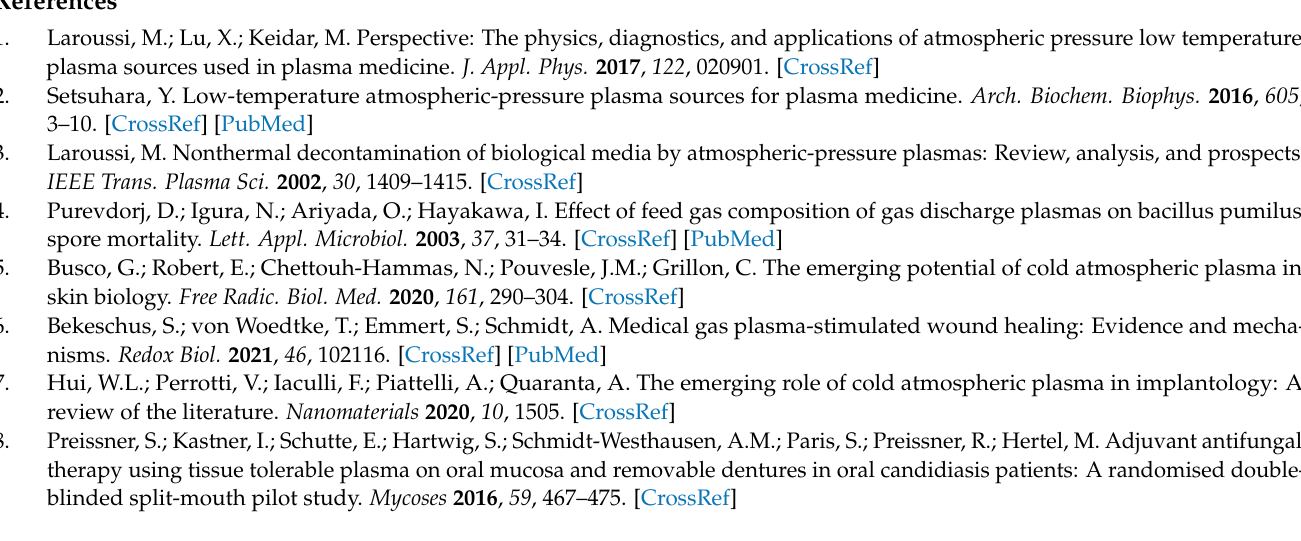
Supplemental Figure S2. Cellular secretion profiles at 48 h. levels of 13 different cytokines and chemokines in cellular supernatants 48 h after onset of human HaCaT cultures on gas